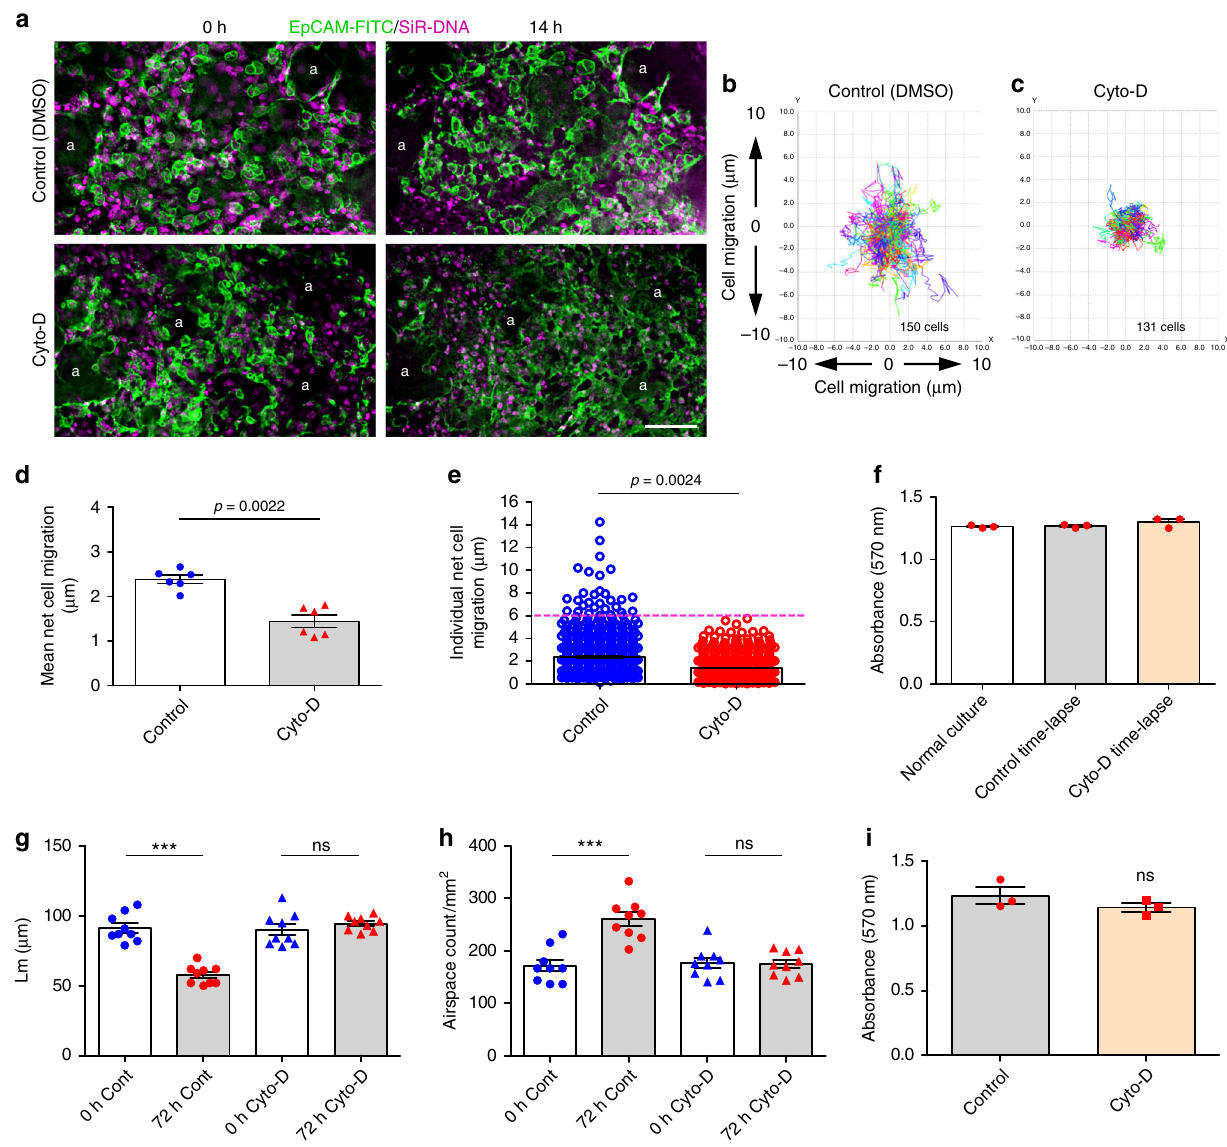
Fig. 8 Cytochalasin D inhibits ex vivo alveologenesis. Deconvolved, wide fi eld single plane z-stack images from 14 h time-lapse videos (Supplementary movies 15A, B) of control ( a , top panels) and cyto-D treated ( a , bottom panels) P3 PCLS labelled with EpCAM-FITC (green) and SiR-DNA (magenta) at 0 and 14 h. Individual cell tracking over 14 h in a single fi eld from P3 PCLS treated with DMSO, control ( b ) or 100 ng/ml cyto-D containing media ( c ). Mean net epithelial cell migration over 14 h in DMSO control or 100 ng/ml cyto-D containing media ( d ), n = 3 independent experiments using three separate mice; two fi elds were quanti fi ed from each PCLS from each mouse per condition, per experiment. Each dot represents mean net epithelial cell migration per fi eld. Mann-Whitney U -test, p = 0.0022. Individual net cell migration in cyto-D treated vs. DMSO control P3 PCLS after 14 h of time-lapse imaging (each dot represents a single cell) ( e ). A total of 778 cells in DMSO control and 718 cells in cyto-D treated P3 PCLS were tracked. Student t -test; n = 3 independent experiments using three separate mice, 2 fi elds were quanti fi ed from each PCLS from each mouse per condition, per experiment, p = 0.0024. MTT cell viability assay comparing P3 PCLS after 15 h under normal culture conditions or after 15 h time-lapse imaging in DMSO control or cyto-D containing media ( f ), n = 3 independent experiments using 3 separate mice, quanti fi cation was from a single PCLS per condition, per experiment, one-way ANOVA with Tukey ’ s post hoc test. Mean linear intercept (Lm) ( g ) and airspace count ( h ) from H&E sections of P3 PCLS at 0 and 72 h of ex vivo culture; n = 3 independent experiments using 3 separate mice; 3 H&E sections from each PCLS from each mouse were quanti fi ed per group, per experiment, each dot represents per fi eld count ( g , h ); ns = not signi fi cant, *** p < 0.001; one-way ANOVA with Tukey ’ s post hoc test. MTT cell viability assay on P3 PCLS at 0 and 72 h of culture in DMSO control or cyto-D containing media ( i ), n = 3 independent experiments using three separate mice, quanti fi cation was from a single PCLS per condition, per experiment; ns = not signi fi cant; paired Students t -test. Error bars are de fi ned as s.e.m migrated ≥ 6 µm in cyto-D-treated PCLS ( p = 0.0024, Fig. 8e). unaltered Lm (90.11 µm at 0 vs. 94.56 µm at 72 h; Fig. 8g) and Cyto-D treatment did not cause signi fi cant cell toxicity (Fig. 8f). airspace count (177 airspaces/mm 2 at 0 vs. 175.4 airspaces/mm 2 at 72 h; Fig. 8h) in P3 PCLS after 72 h culture; compared to In line with blebbistatin data, morphometric analysis (Lm and DMSO control PCLS where Lm was signi fi cantly reduced ( p < airspace count) showed that cyto-D treatment of PCLS for 72 h 0.001; Fig. 8g) and airspace count increased by 1.5-fold in 72 h signi fi cantly restricted in vitro alveologenesis, as shown by NATURE COMMUNICATIONS| (2019) 10:1178